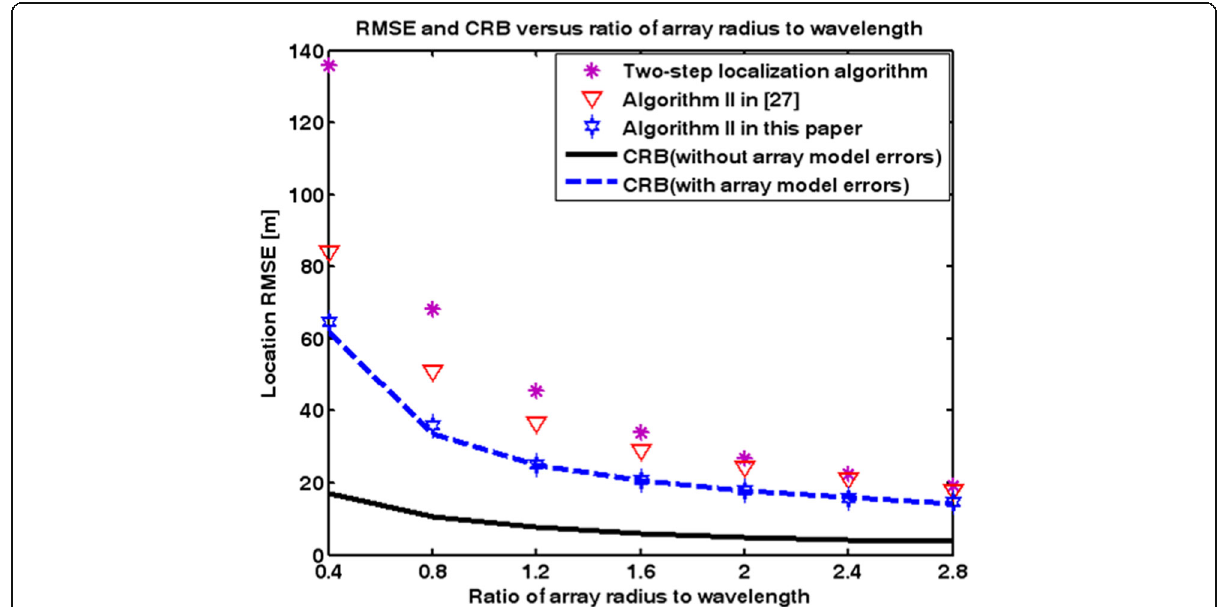
Fig. 11 RMSEs of localization methods and the corresponding CRBs as a function of ratio of array radius to wavelength for case of known signal